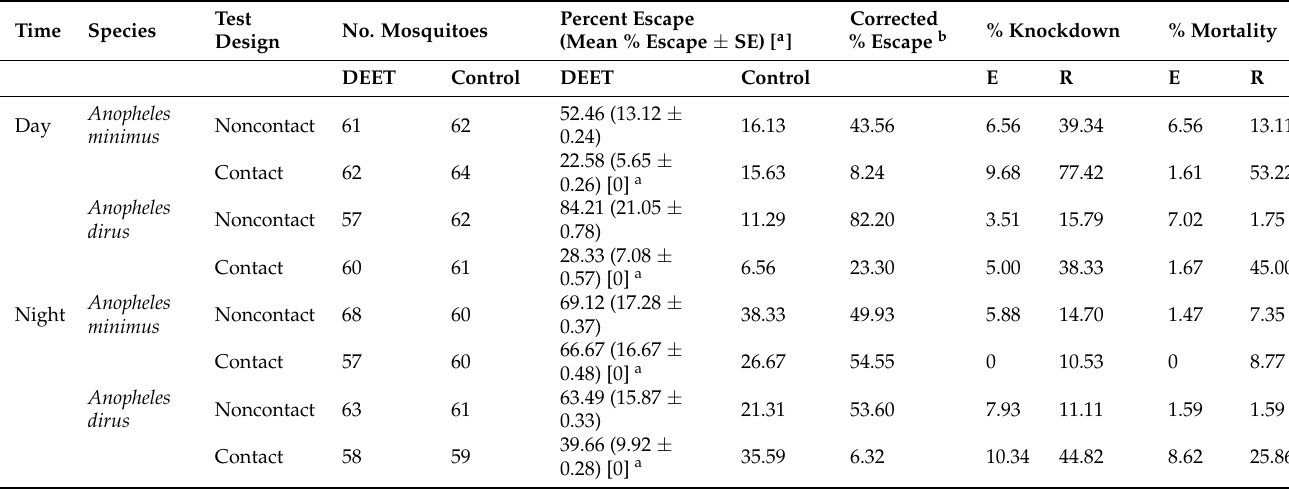
Table 1. The average percentage of escaped, knockdown, and 24-h mortality of Anopheles minimus and Anopheles dirus from DEET exposure chambers conducted between day and night using the excito-repellency assay system.